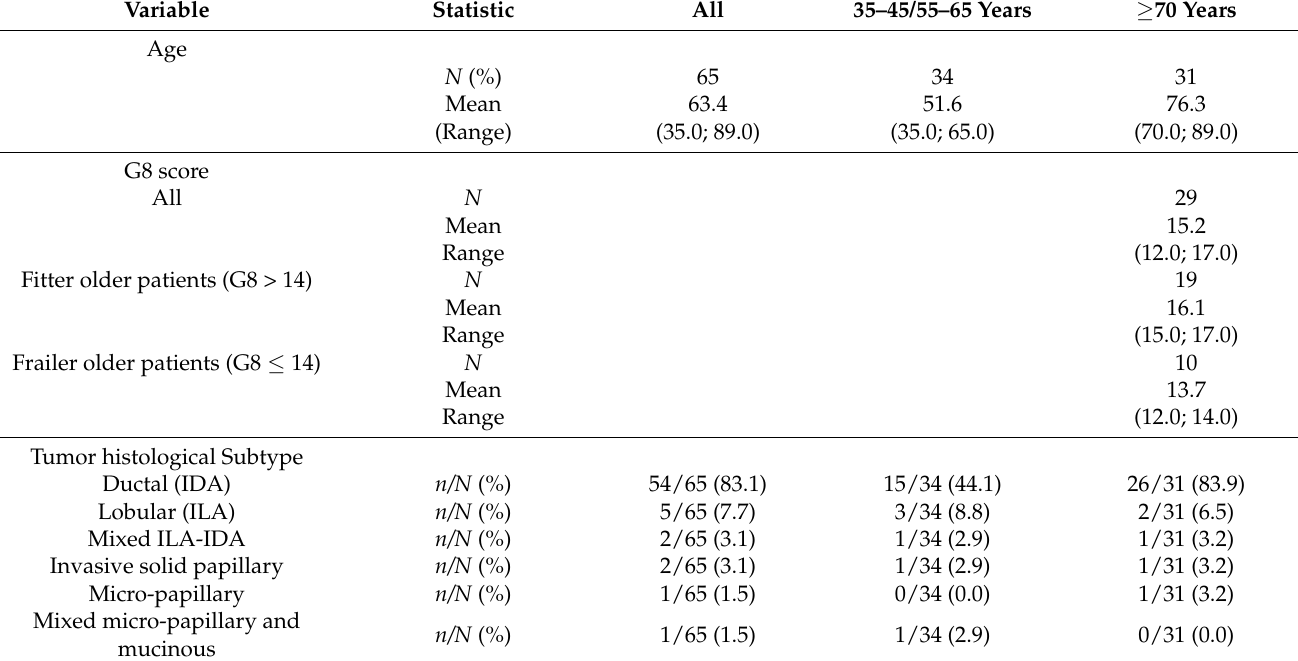
Table 1. Patient, tumor, and tumor infiltrate characteristics. Definitions: sTILs infiltration (‘low’: <10%, ‘intermediate’: 10–40%, ‘high’: >40%), CD3 and CD8 infiltration (cutoffs based on IQR of CD3 and CD8 density: ‘low’: lowest 25%, ‘high’: highest 25%). The inclusion criteria were based on clinical estimate of the tumor size (1.5 cm or bigger) and on the grading (grade II or III) based on the core needle biopsy. Enough tumor material was available for 62 out of the 65 patients. The table reports pathological tumor size and tumor grade measured on the resection specimen after surgery, explaining a few discrepancies between selection criteria and results on the surgical specimen reported here. For two patients in the old group the G8 scores were not